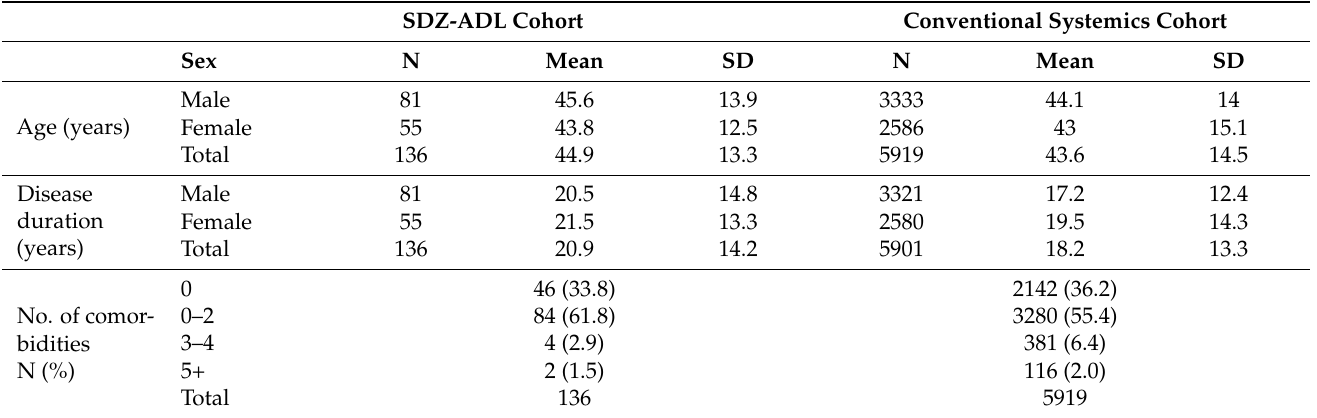
Table 2. Baseline disease characteristics of patients registered in the SDZ-ADL and conventional systemic cohorts from the safety